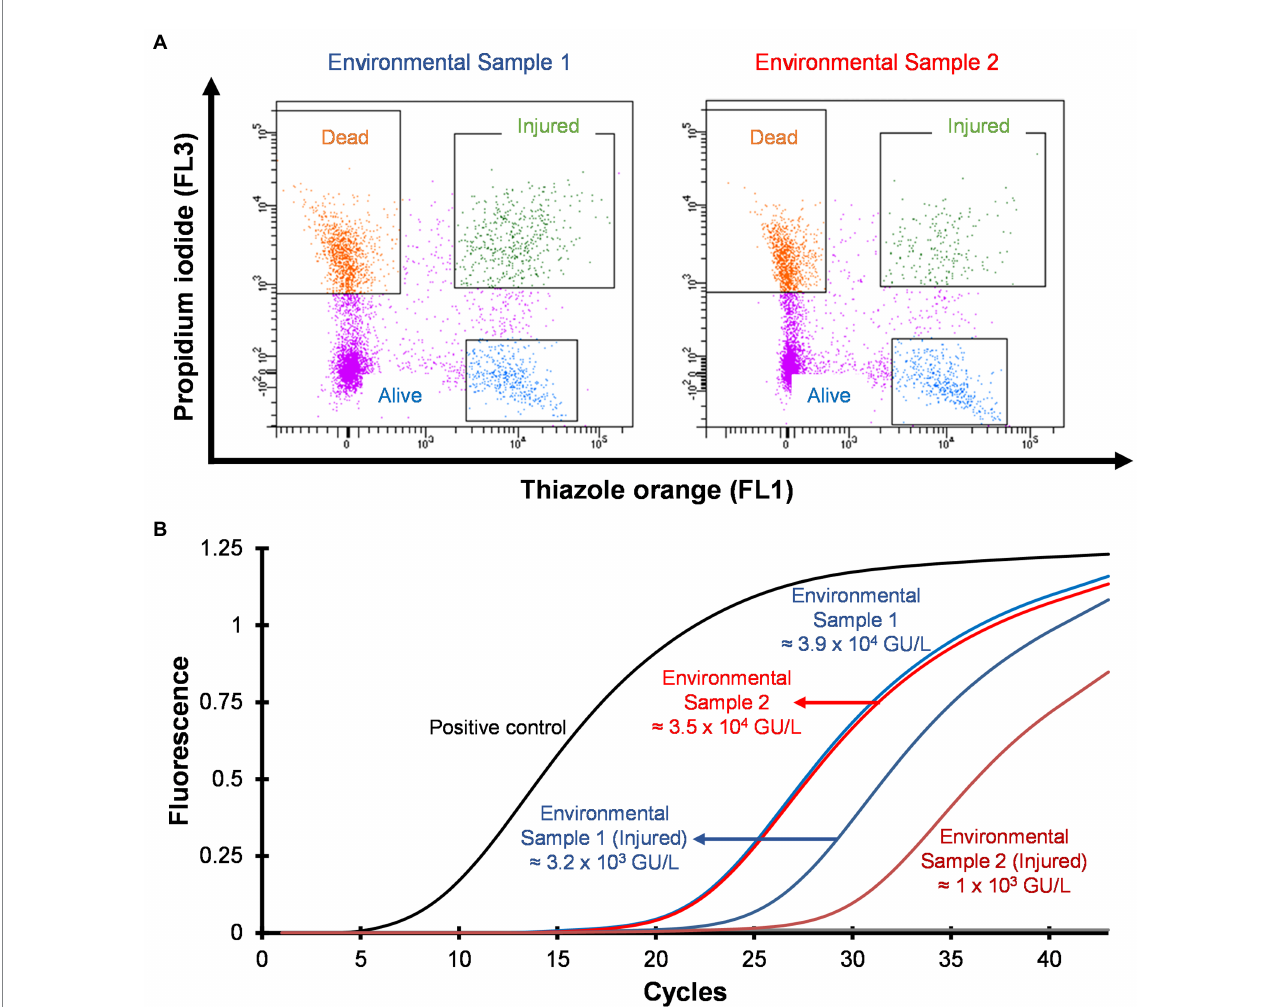
FIGURE 7 Detection and quantification of VBNC L. pneumophila from potable water samples. (A) Cytograms of culture negative potable water samples. (B) qPCR of whole water sample and VBNC Legionella and estimation of GU/L after viability cell sorting using flow cytometry shown in (A) . This image clearly demonstrates the difference in the concentration of Legionella , indicating presence of dead Legionella of its DNA in the water